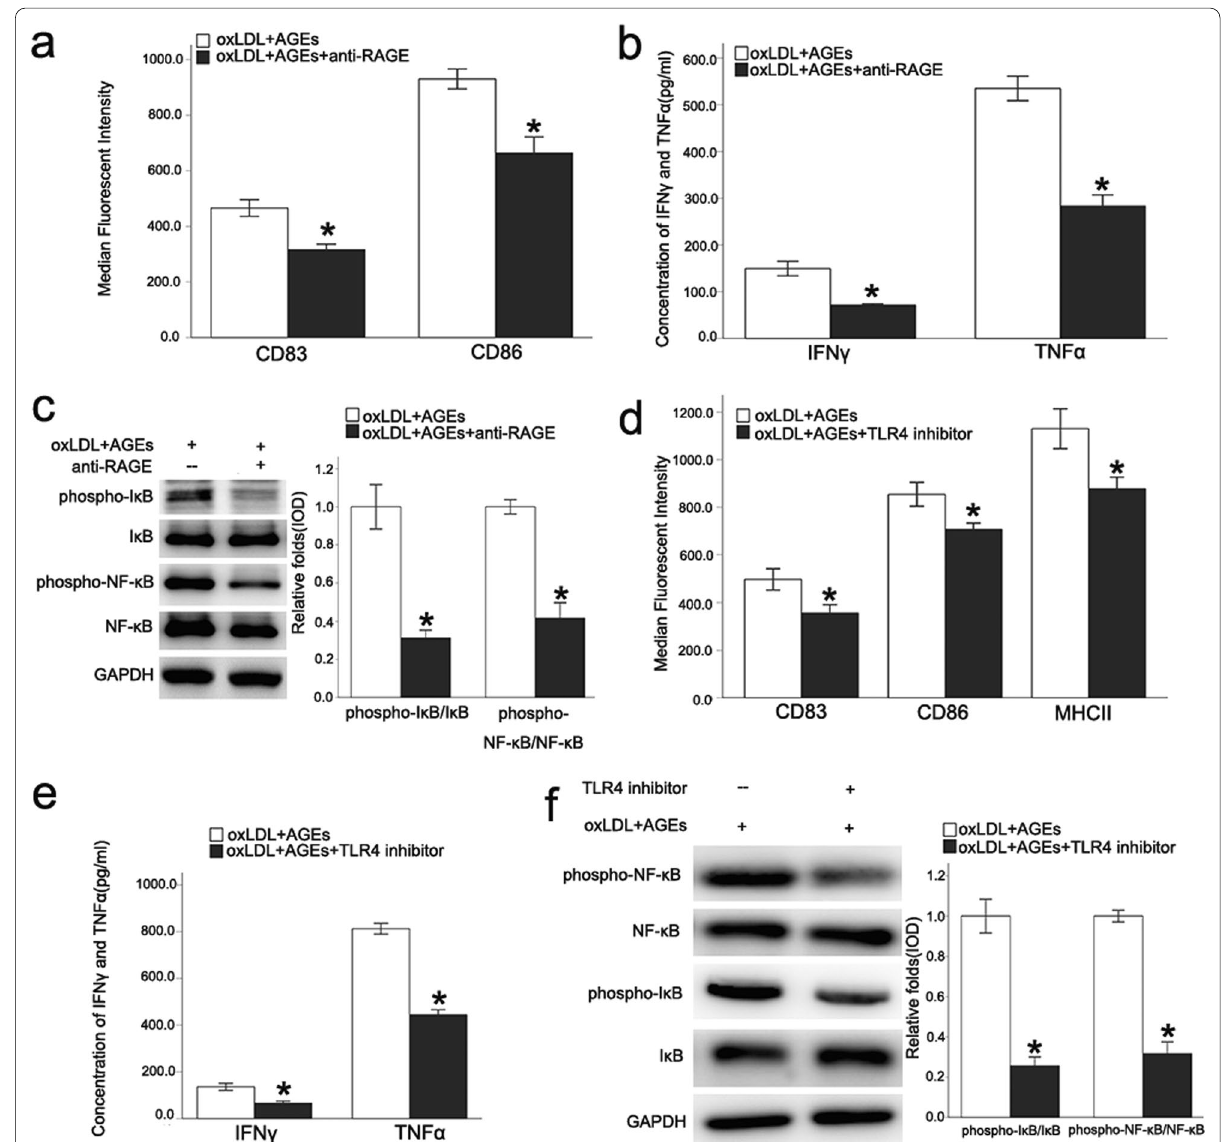
Fig. 3 RAGE antibodies and TLR4 inhibitors inhibit the immune maturation of DCs. After pretreatment with RAGE neutralizing antibody, the expression of CD83 and CD86 were decreased, and accompanied by a significant down-regulation of secretion of the inflammatory cytokines and IκB/NF-κB phosphorylation ( a – c ). In the TLR4 inhibitor group, CD83 and CD86 were down-regulated, and the ability of BMDCs to release inflammatory cytokines also was decreased ( d , e ). Combined with the decreased expression of p-NF-κB and p-IκB ( f ). Values, mean *p < 0.05 vs. oxLDL AGEs group; oxLDL oxidized low density lipoprotein, AGEs advanced glycation end-products; RAGE Receptor for advanced + glycation end products, NF-κB nuclear factor-κB, IFNγ IFN gamma; TLR4 Toll-like receptor 4, TNFα Tumor necrosis factor alpha